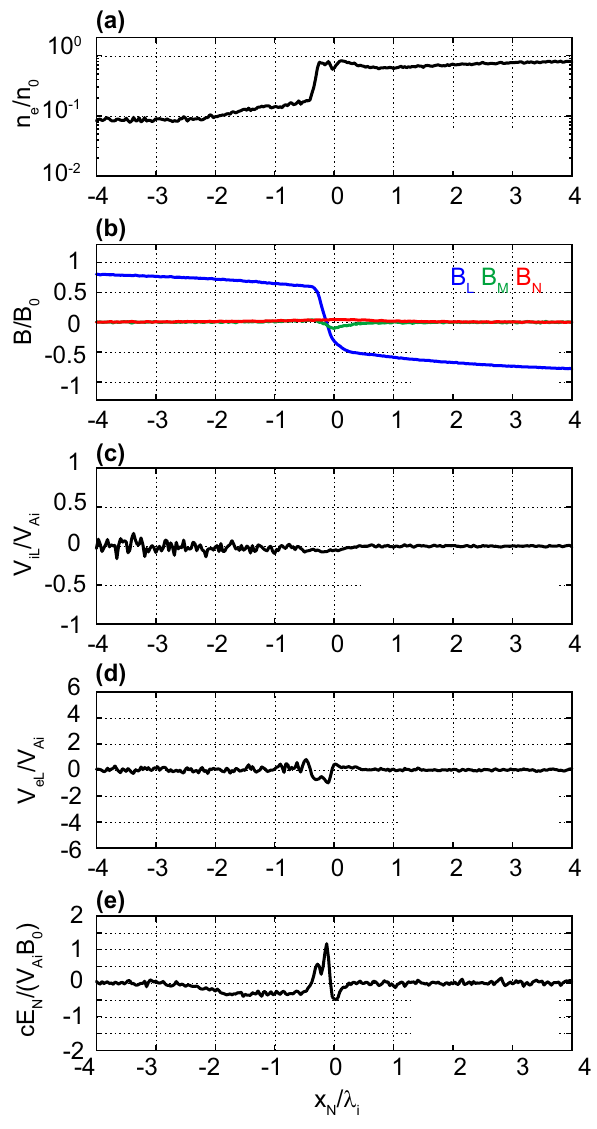
Fig. 10. The vertical structure of the X-line ( x L =12) under the den- sity asymmetry. The format is the same as Fig. 5.